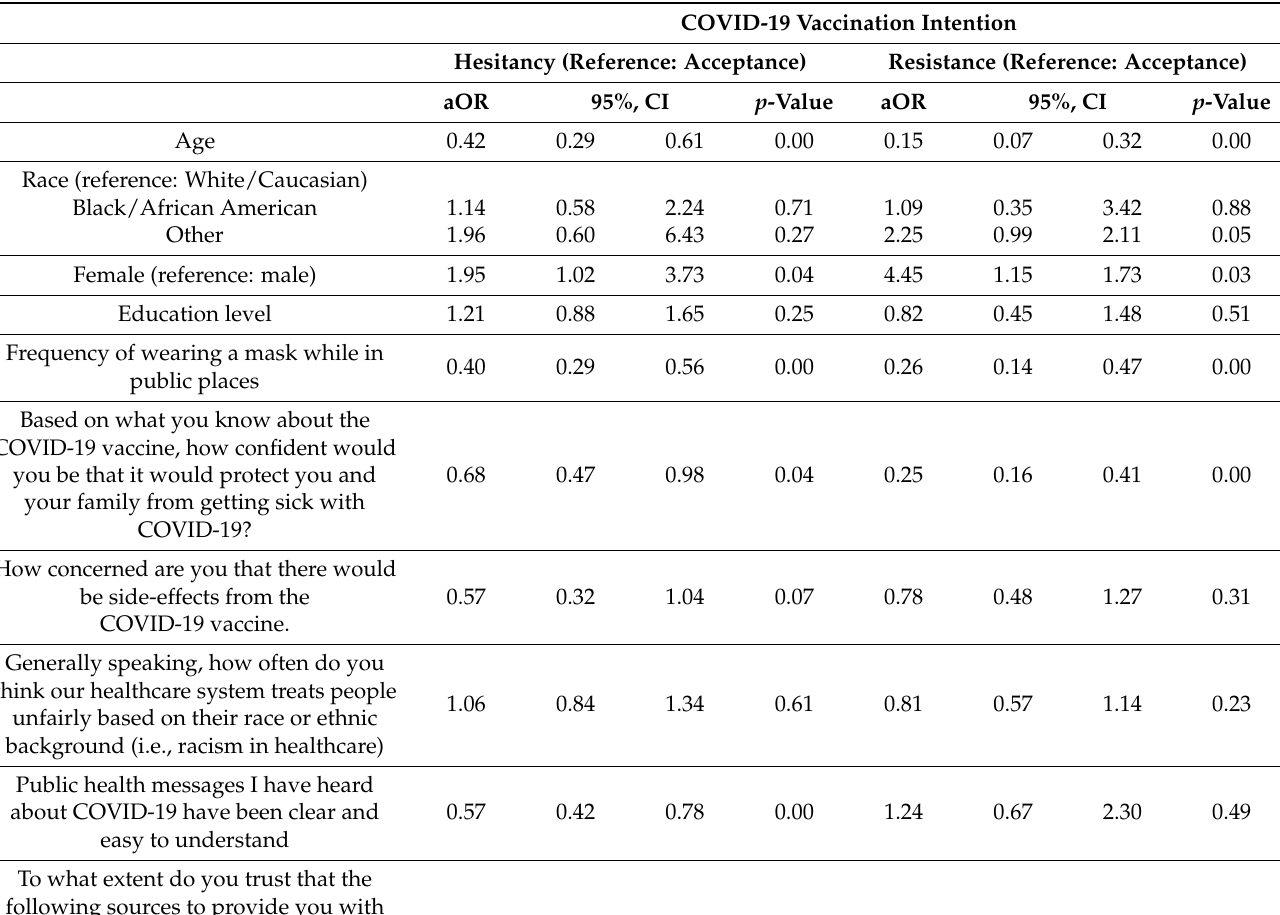
Table 3. Multinomial Regression Predicting COVID-19 Vaccination Intention. COVID-19 Vaccination